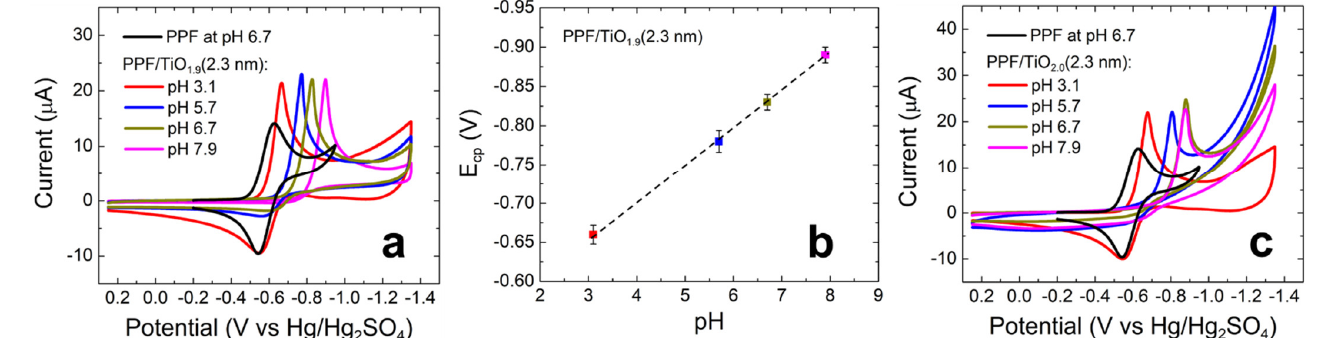
Figure 6. CVs obtained using ( a ) PPF/TiO 1.9 (2.3 nm) and ( c ) PPF/TiO 2.0 (2.3 nm) electrodes. The solutions contained aqueous 1.0 mM [Ru(NH 3 ) 6 ]Cl 3 and 0.10 M phosphate buffer at the pHs indicated in the legends. The electrode potential was scanned between 0.25 and −1.35 V at 0.050 V/s. The experiments were carried out in triplicate for each electrode configuration using independently prepared electrodes to ensure reproducibility. ( b ) Plot showing the relationship between E cp and pH for the indicated working electrode configuration. The error bars in ( b ) represent the standard deviations from the mean for three measurements that were carried out using independently prepared electrodes.